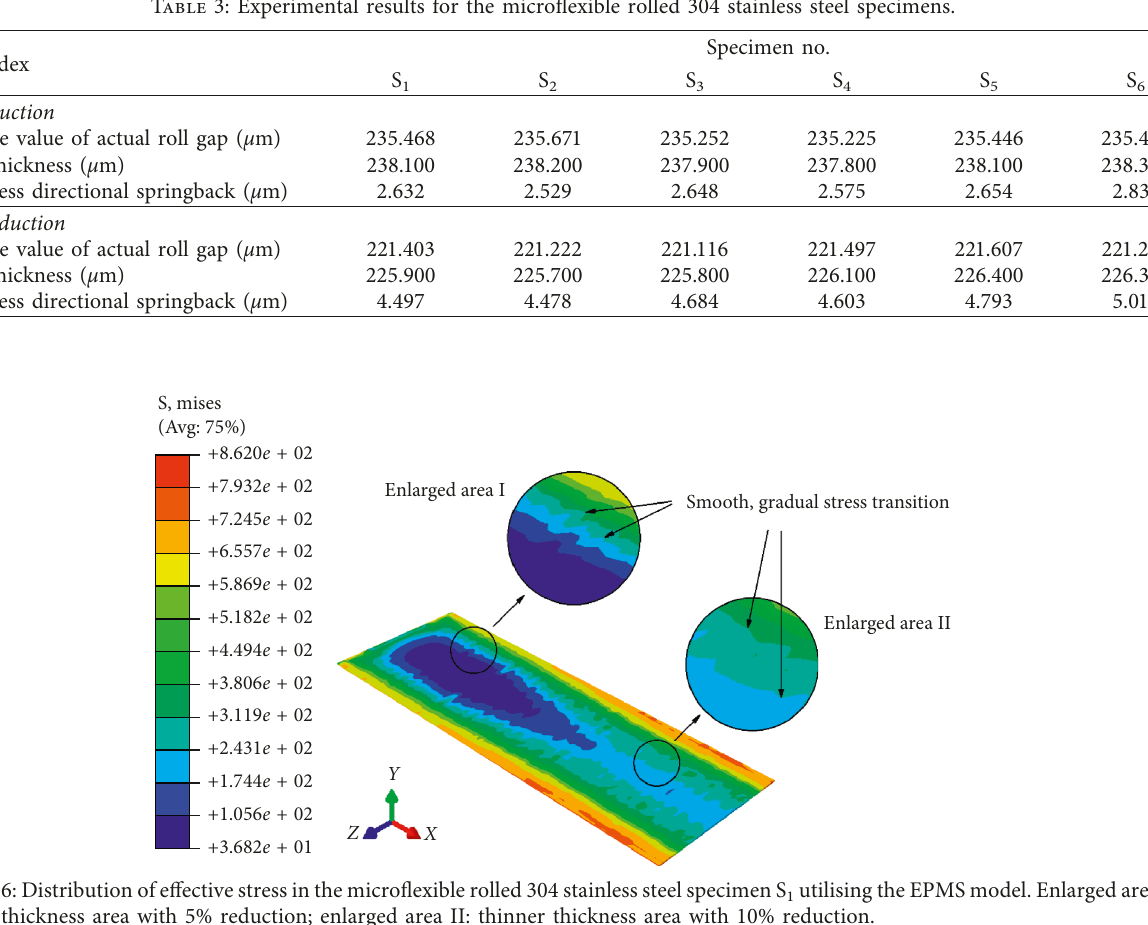
1 utilising the EPMS model. Enlarged area I: